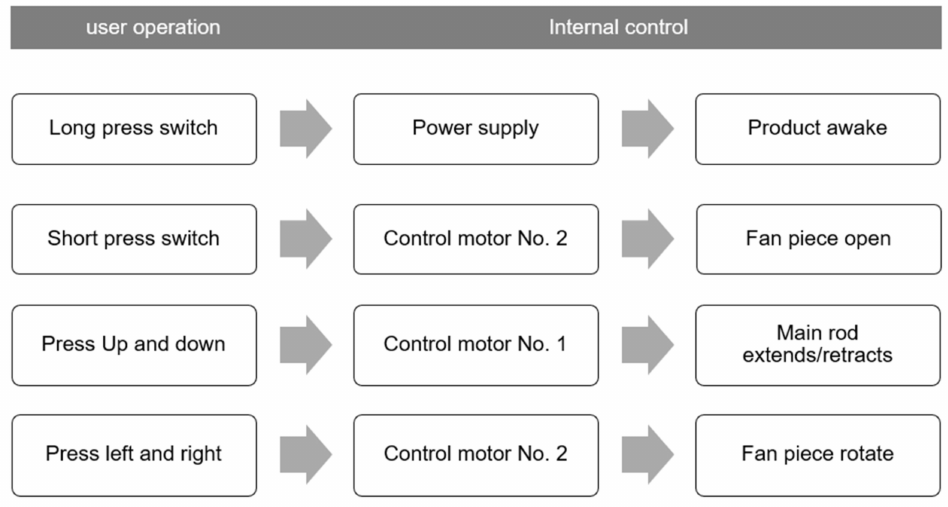
Figure 25. Control wireframes of